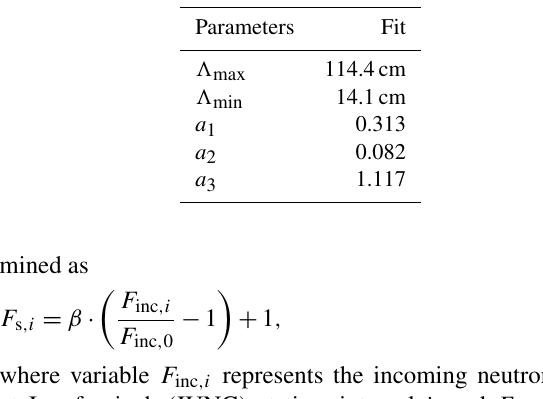
Table 4. The constant parameters of Eq. (6). The fitted parameters a 1 , a 2 and a 3 are without units.